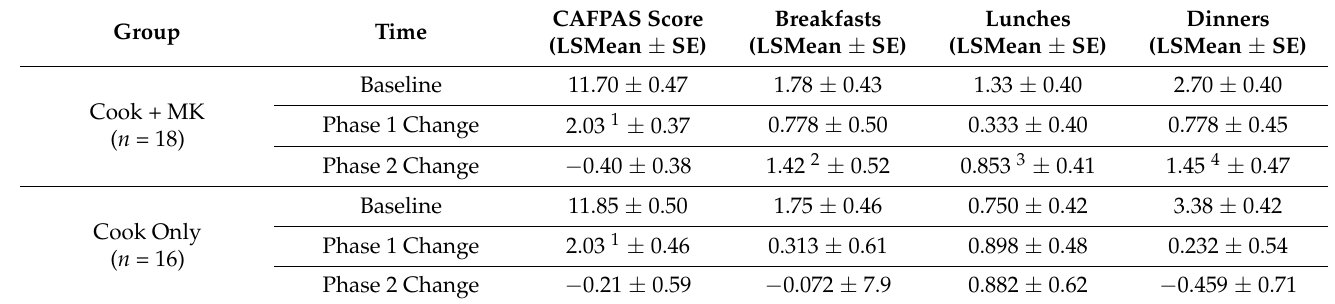
Table 2. Mean food agency (CAFPAS) scores and mean meals cooked per week at baseline and change following each intervention